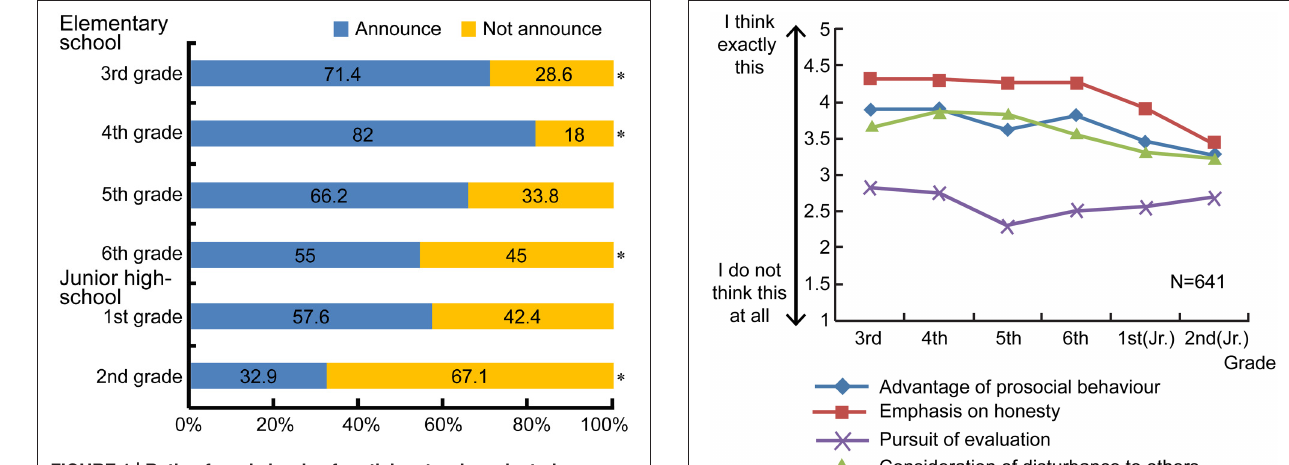
FIGURE 1 | Ratio of grade levels of participants who selected “Admit”/“Not Admit” in relation to prosocial behavior. * p < 0.01 .